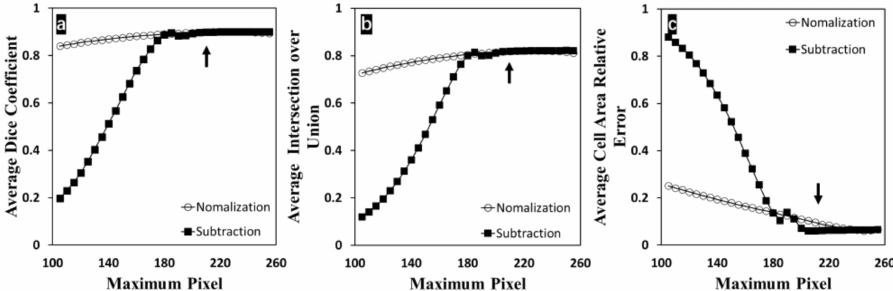
Figure 7. Effect of input image illumination on the proposed cell segmentation method. ( a ) Dice coefficient changed with varying illumination; ( b ) IoU changed with varying illumination; ( c ) relative error on cell growth area measurements changed with respect to varying illumination. Dark arrows indicate the conditions that manual segmentation is infeasible.